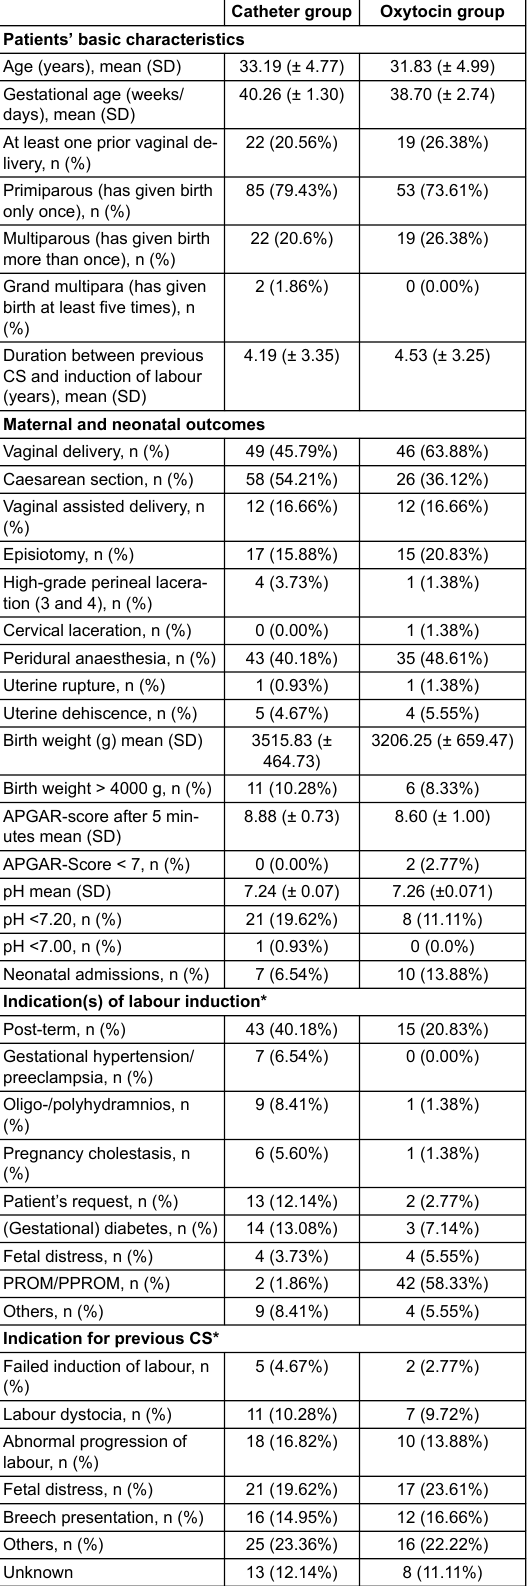
Table 1: Patient’s basic characteristics and materno-fetal outcomes in the cohorts (induction method catheter and oxytocin after caesarean